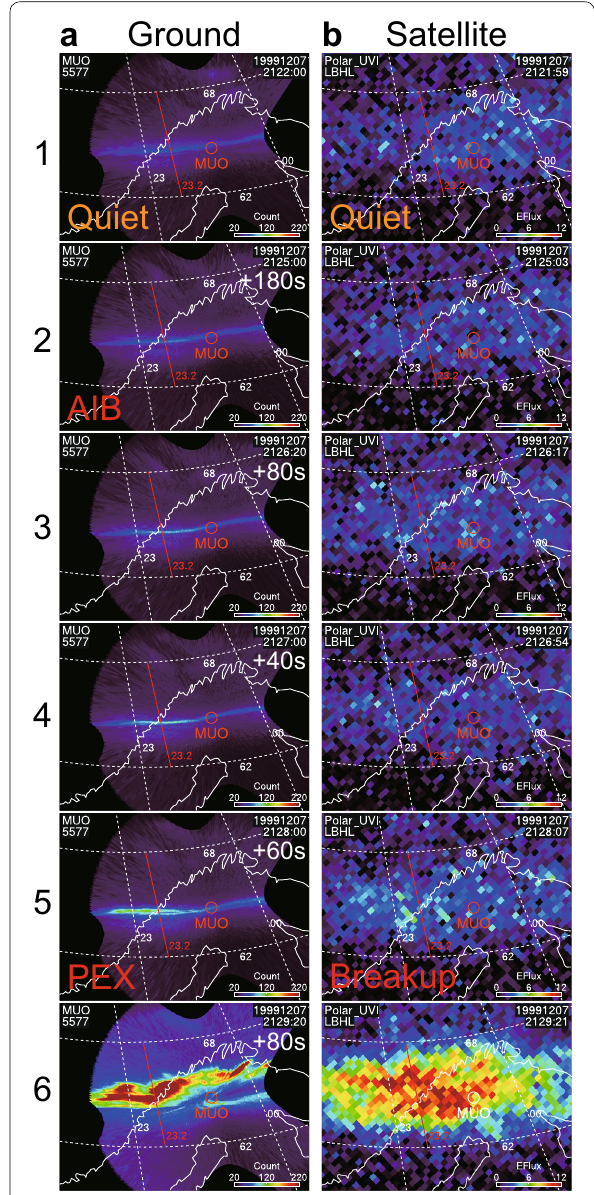
Fig. 6 Comparison of a ground‑based and b satellite‑based auroral images on December 7, 1999. The time sequence of selected auroral images is shown from top to bottom. All images are projected to the same area in geodetic coordinates. a Ground‑based all‑sky images (ASIs; 557.7 nm) at the Muonio station (MUO) in Finland. These ASIs were selected to show the observed instances ( a1 ) during the quiet interval, ( a2 ) at the start of Akasofu initial brightening (AIB), a3 – a4 during AIB, a5 at the start of poleward expansion, and a6 during poleward expansion. b Global images (170 nm) taken by the Polar satellite ultraviolet imager (UVI). Each image was selected to form a pair with an ASI in a within 7 s. A comparison of a and b reveals that the longitudinally extended brightening (AIB) can be marginally observed in a2 and is evident in a3 – a4 but not in b2 – b4 . In contrast, the brightening a5 that corresponds to the beginning of the poleward expansion was simultaneously observed in